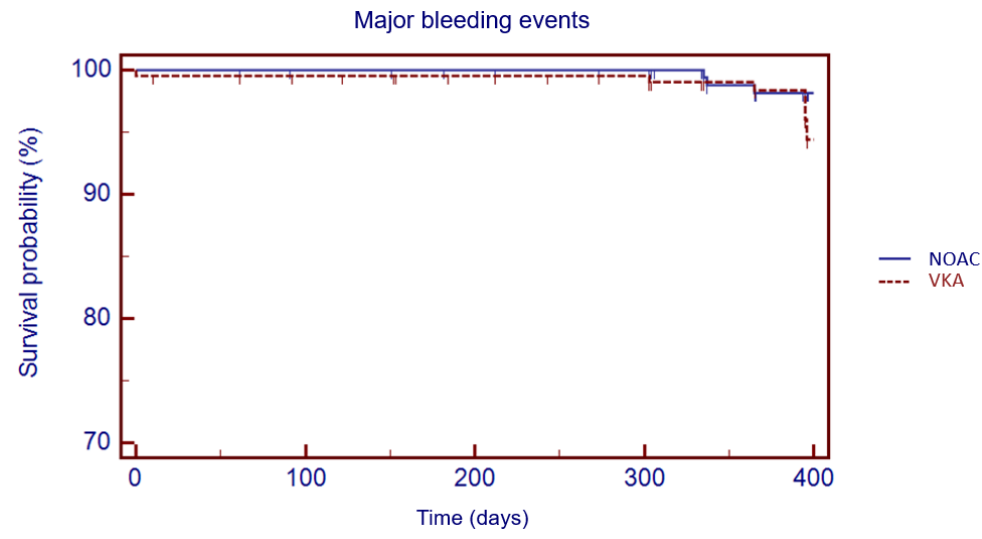
Figure 4. Kaplan–Meier cumulative probability of major bleedings event-free survival in NOAC and VKA treatment group.